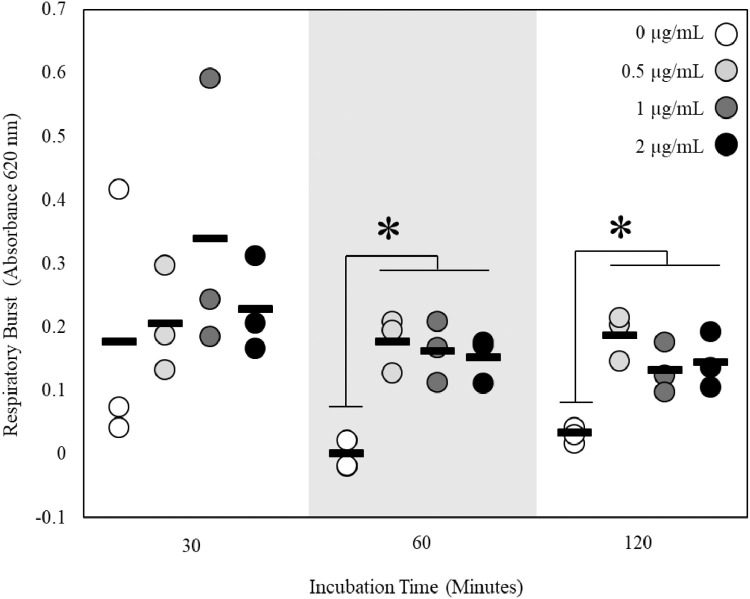
Determination of optimum incubation time and phorbol 12-myristate 13-acetate (PMA) dose (as indicated by shading) for respiratory burst in adult fathead minnow kidney cells (n = 3). Bars indicate mean. Asterisks indicate significant differences between doses within a timepoint.